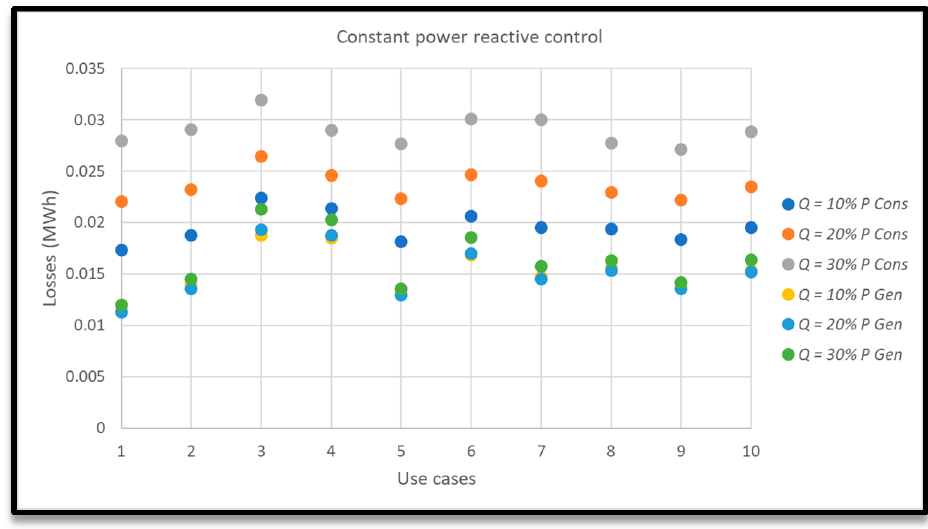
Figure 6. Constant power reactive control: Losses (More information see Table A3 in Appendix C).